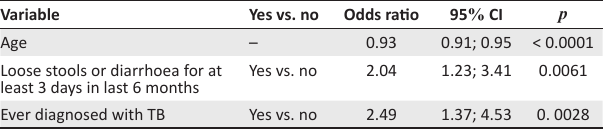
TABLE 6: Reported clinical manifestations associated with HIV status (urban).